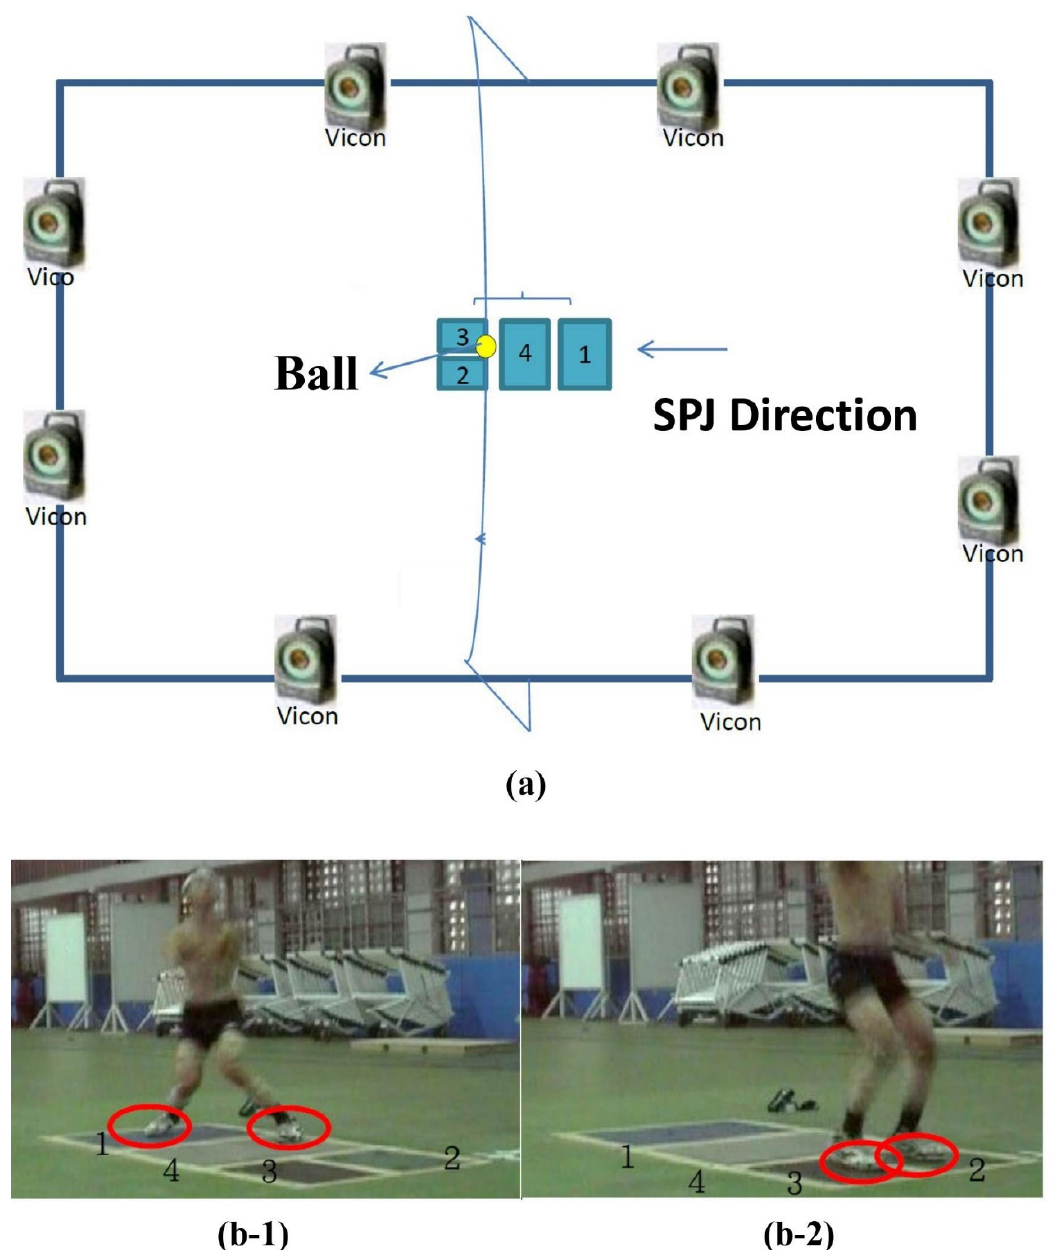
Figure 1. ( a ) The experimental set-up of spike jump; ( b-1 ) take-off and ( b-2 ) touchdown during spike jump.